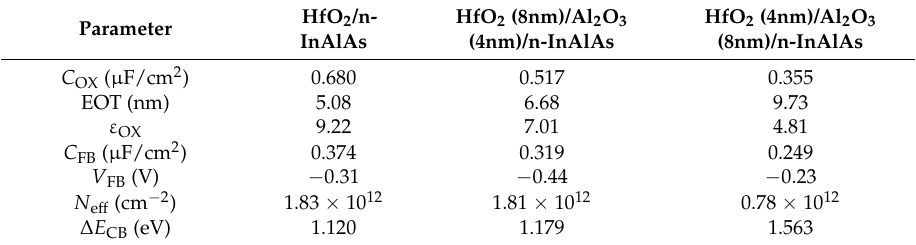
Table 2. Physical and electrical parameters of the HfO 2 /n-InAlAs and HfO 2 –Al 2 O 3 /n-InAlAs MOS